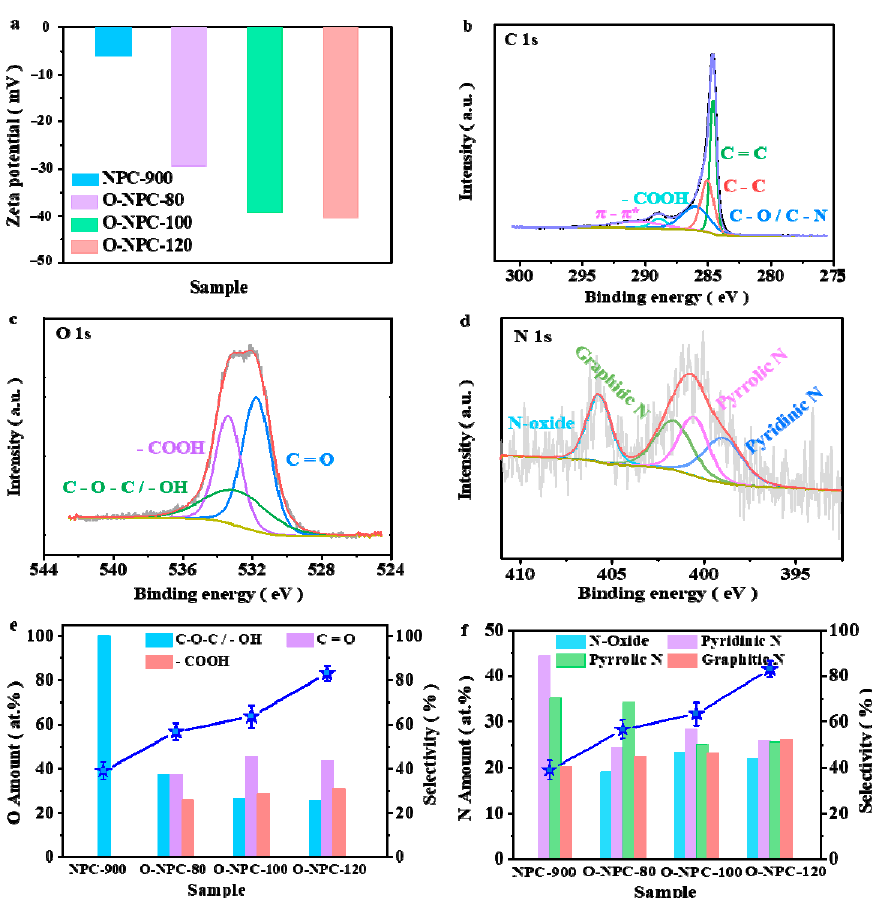
Figure 5. ( a ) Zeta potential of catalysts in water (pH = 7). XPS spectra of O-NPC-120 ( b ) C1s, ( c ) O1s, ( d ) N1s. ( e ) A plot of the relationship between the atomic ratio of O and H 2 O 2 selectivity. ( f ) A plot of the relationship between the atomic ratio of N and H 2 O 2 selectivity.